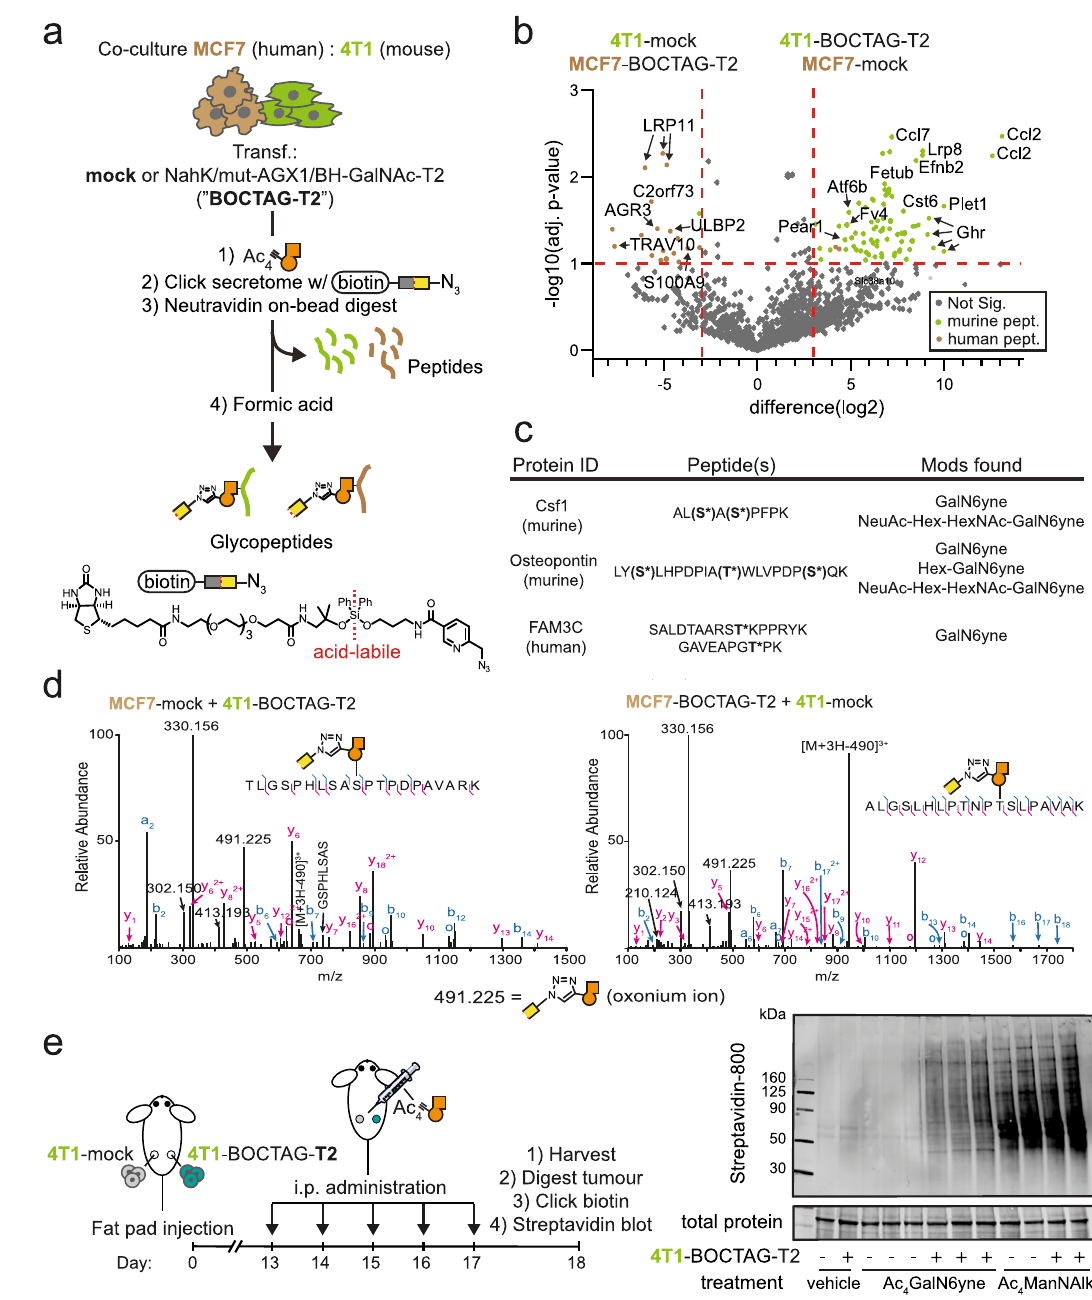
Fig.5|BOCTAGlabelsglycoproteinsinacell-speci fi